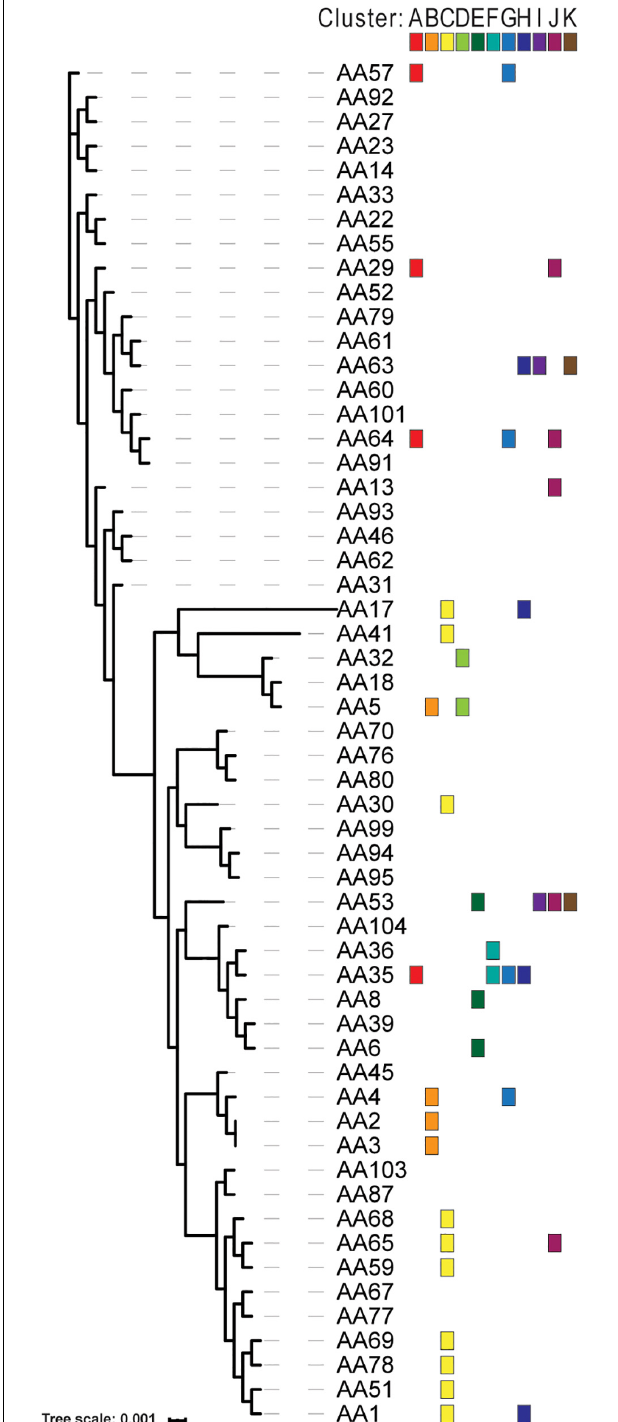
FIGURE 3 | Distribution of plasmid clusters across phylogenomic diversity of Egyptian S. aureus strains. The phylogenomic tree for the isolates was generated based upon the concatenated amino acid sequences of the single copy number genes in the core genome. The tree scale indicates the sequence divergence between the core genome sequence. The color blocks show the presence of a plasmid belonging to 1 of the 11 clusters.